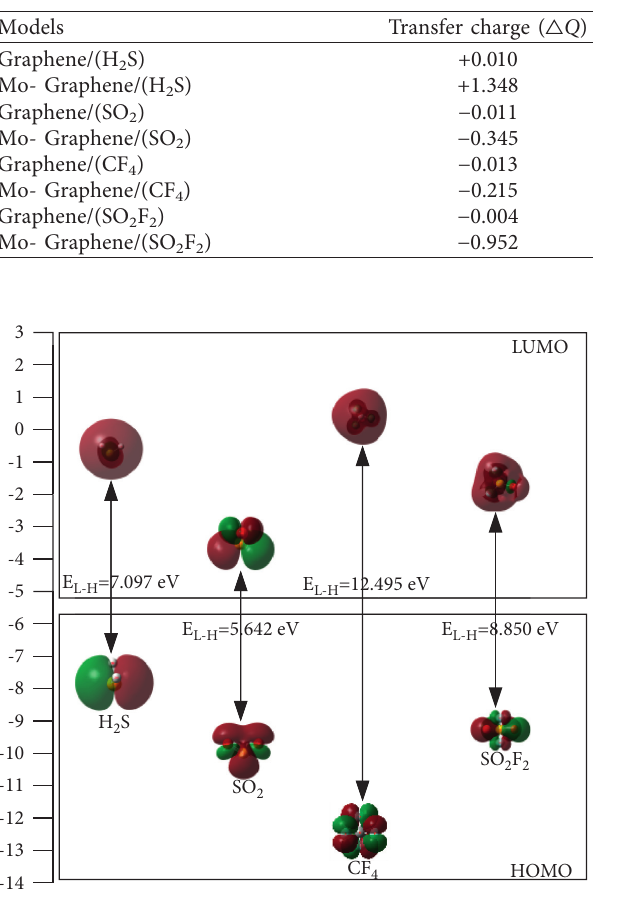
Figure 8: Molecular orbital gap value of H